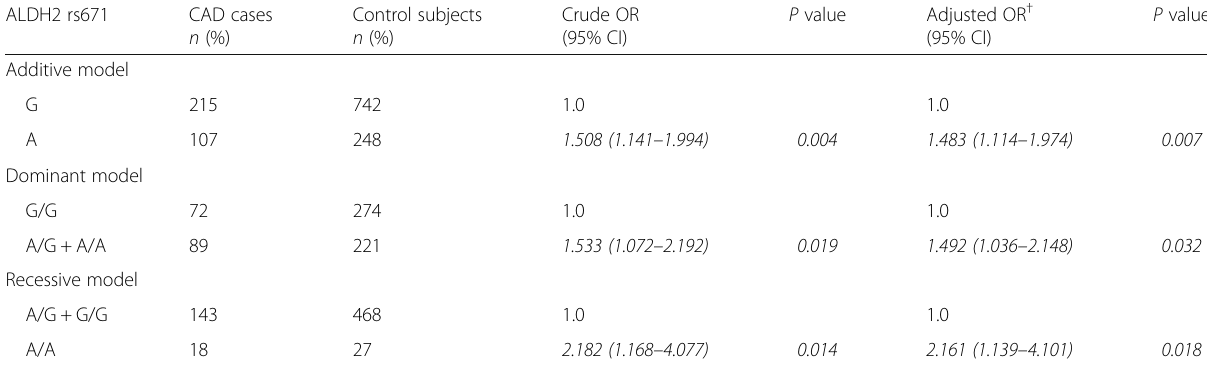
Table 2 Associations of ALDH2 rs671 polymorphism with CAD risk in three genetic models ALDH2 rs671 CAD cases n